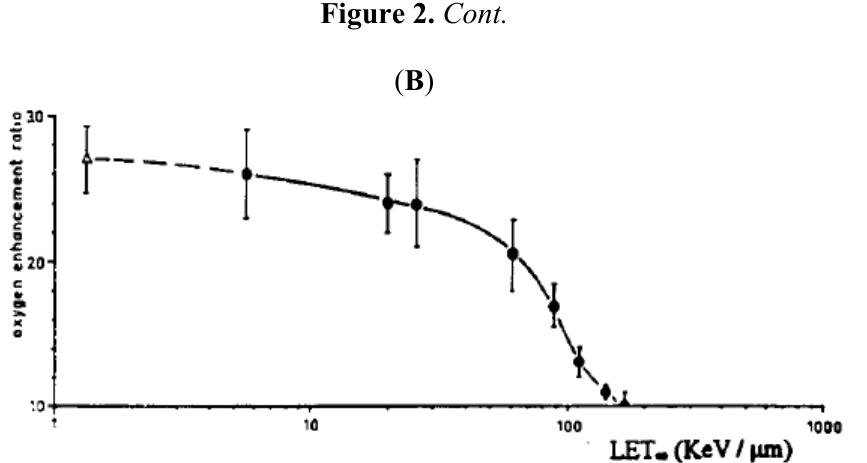
Figure 2. Cont. ( B